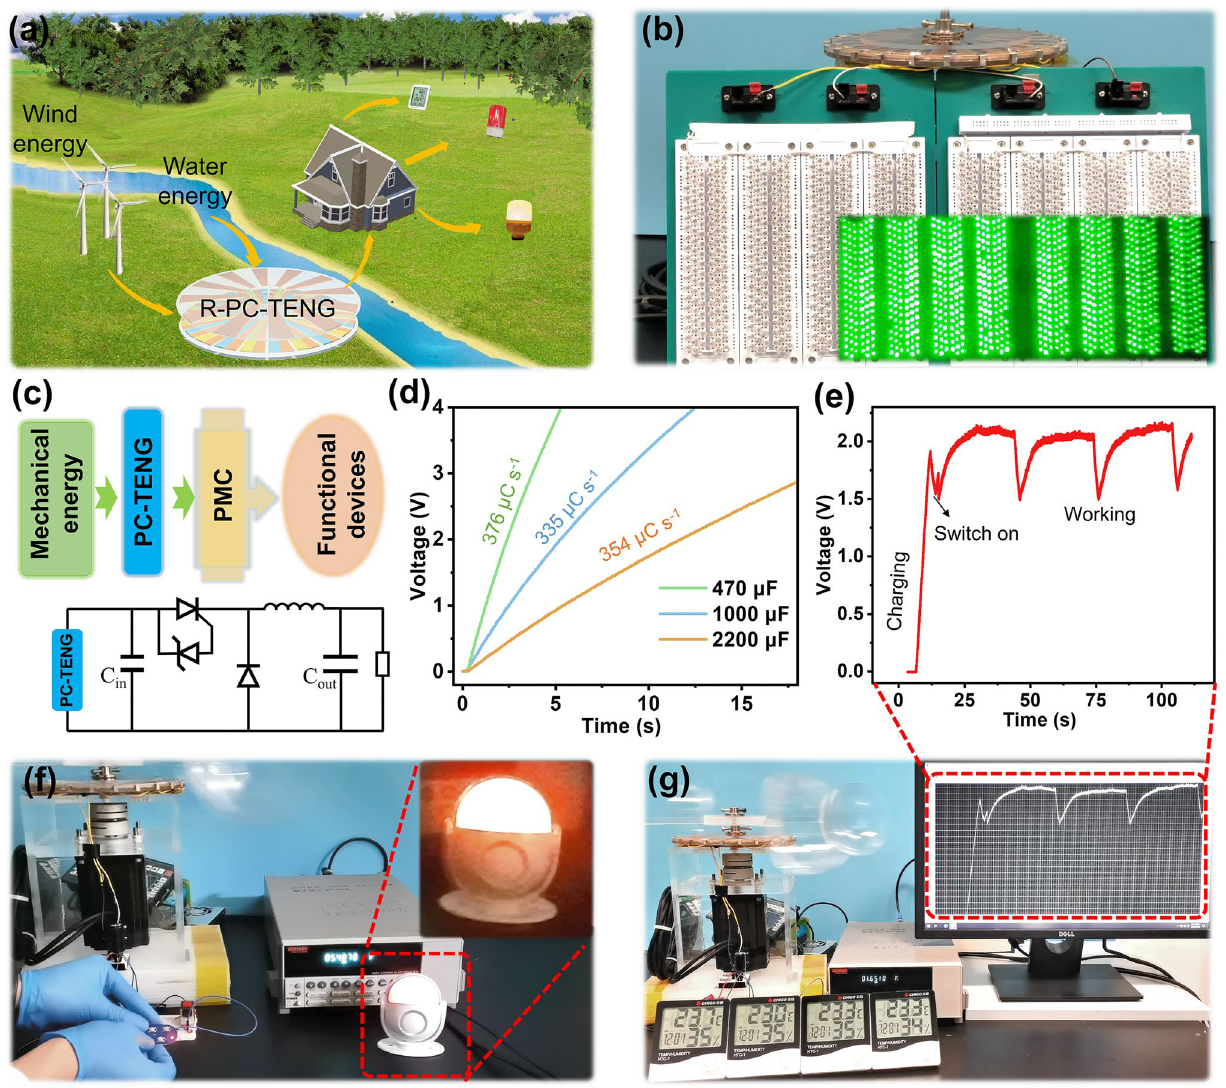
Fig. 4 Application of the R-PC-TENG powering different electronic devices. a The application scenario proposed for the R-PC-TENG. b Dem- onstration of directly powering 944 LEDs at 60 rpm. c System diagram and circuit diagram of the self-powered system for powering electronics with power management. d Voltage curves of charging 470, 1000, and 2200 μF capacitors by using R-PC-TENG device at rotational speed of 60 rpm. f Charging 2.2 mF capacitor while powering an infrared transmitting module under the driven of wind. e, g Charging 470 μF capacitor while powering four hydro-thermometers by wind